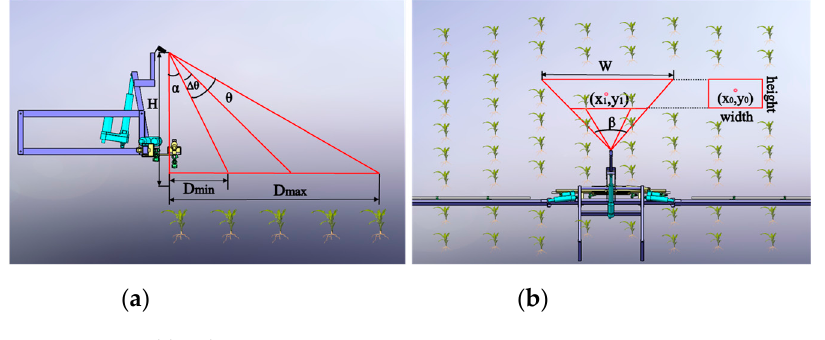
Figure 9. Visual